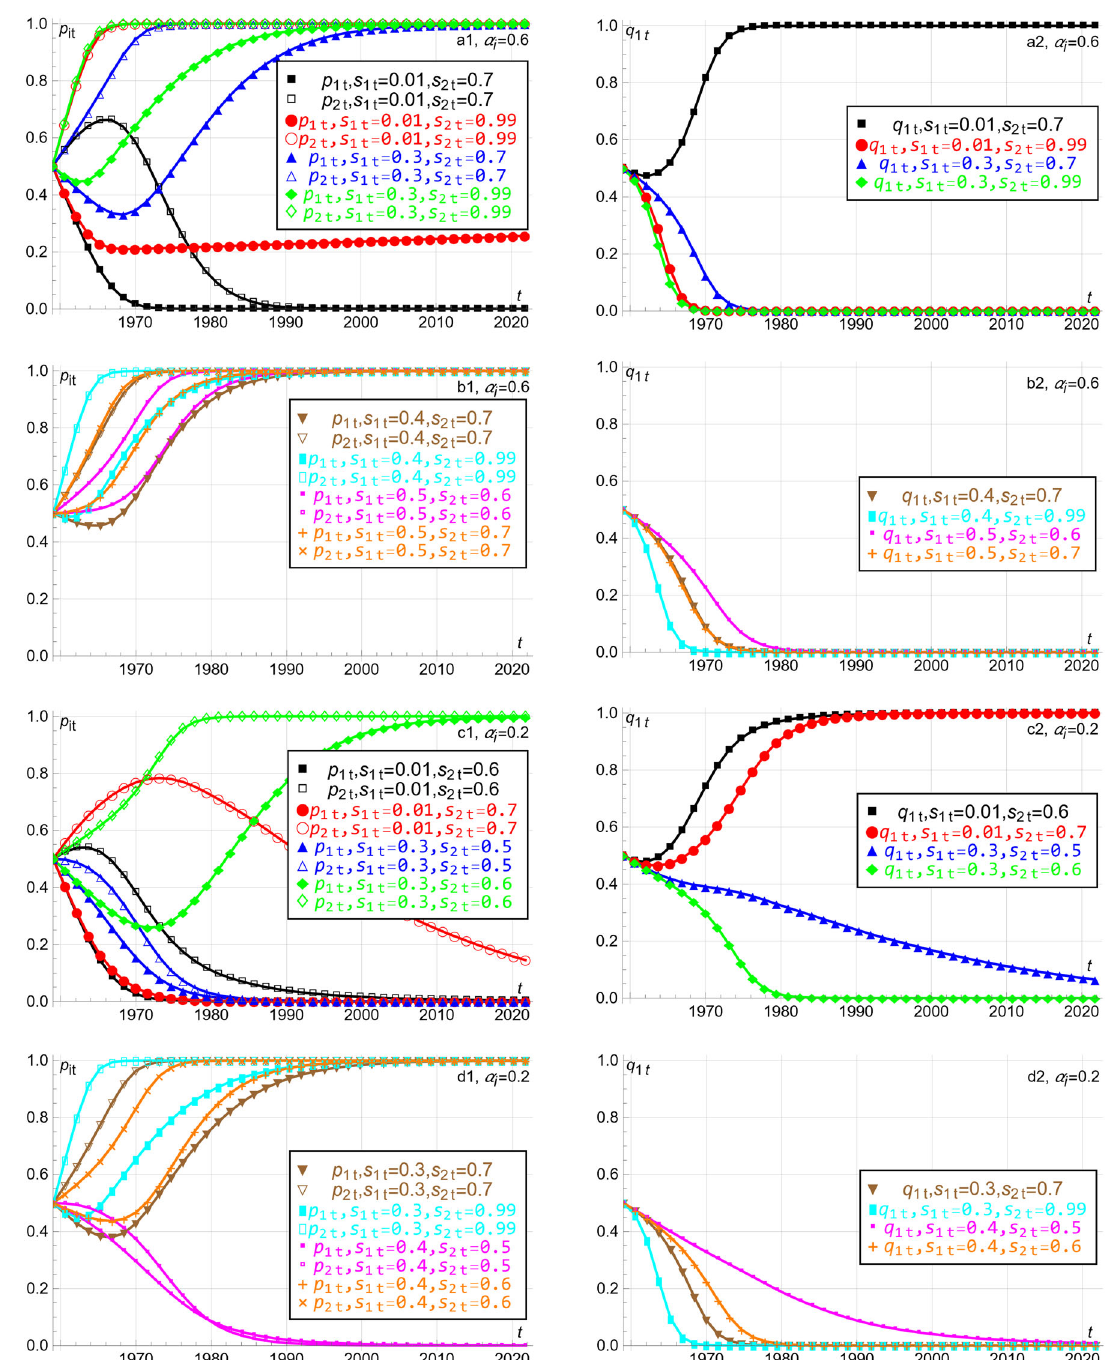
¼ p ¼ k ¼ h ¼ 0 : 5, μ it 0 i 0